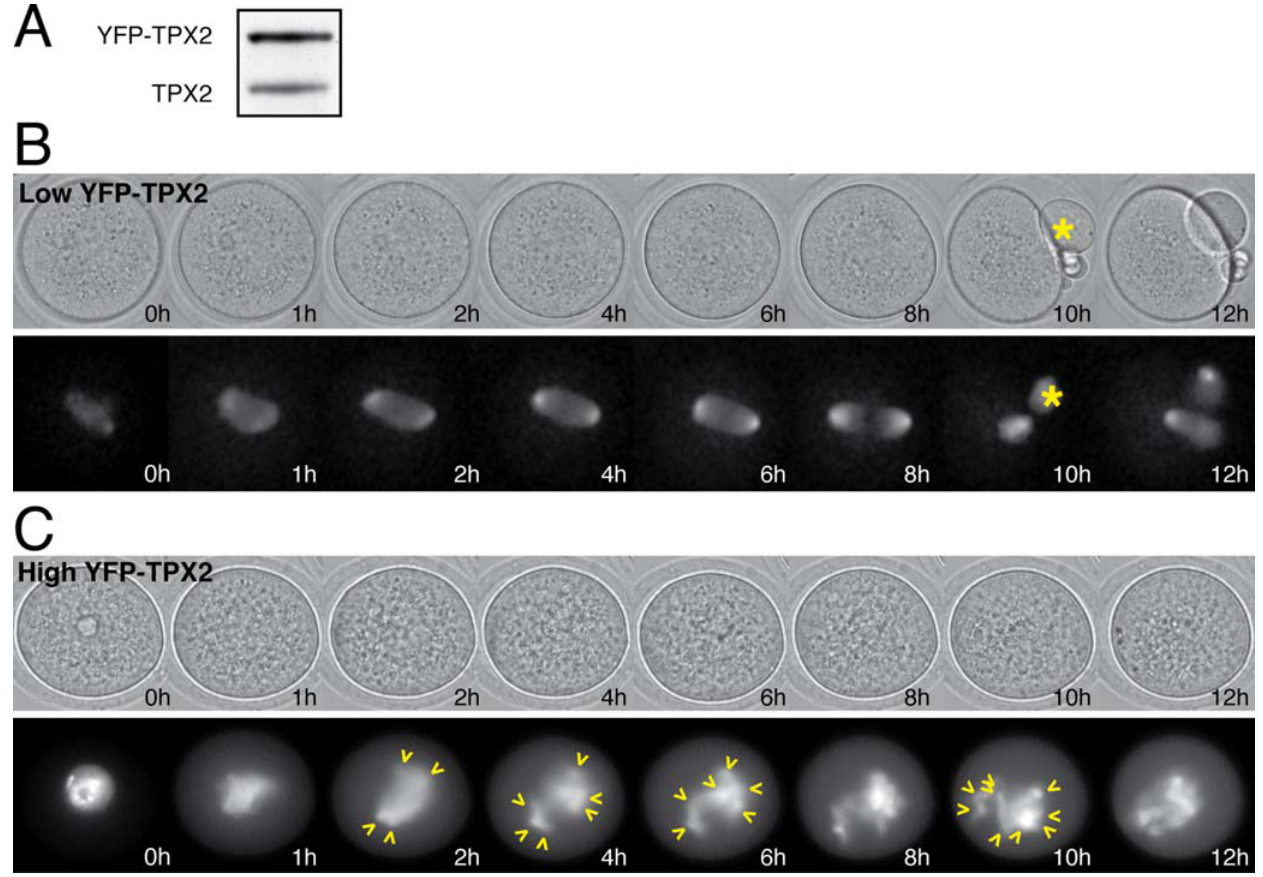
Figure 2. TPX2 overexpresssion induces an arrest in meiosis I. A: Immunoblot analysis of endogenous (TPX2) and exogenous (YFP-TPX2) protein levels in metaphase II oocytes (n=72) expressing low levels of YFP-TPX2. B and C: Representative time-lapse videomicroscopy of oocytes expressing low (B; n=78) or high (C; n=29) levels of YFP-TPX2. Upper panels are the bright field images of the oocyte and the lower panels show the fluorescent YFP signal at the corresponding time points (germinal vesicle breakdown is 0 h). While the polar body extrusion (asterisks) was normal in (B), it was blocked in (C). In this case, multipolar microtubules structures were observed (see arrowheads). doi:10.1371/journal.pone.0003338.g002 PLoS ONE |